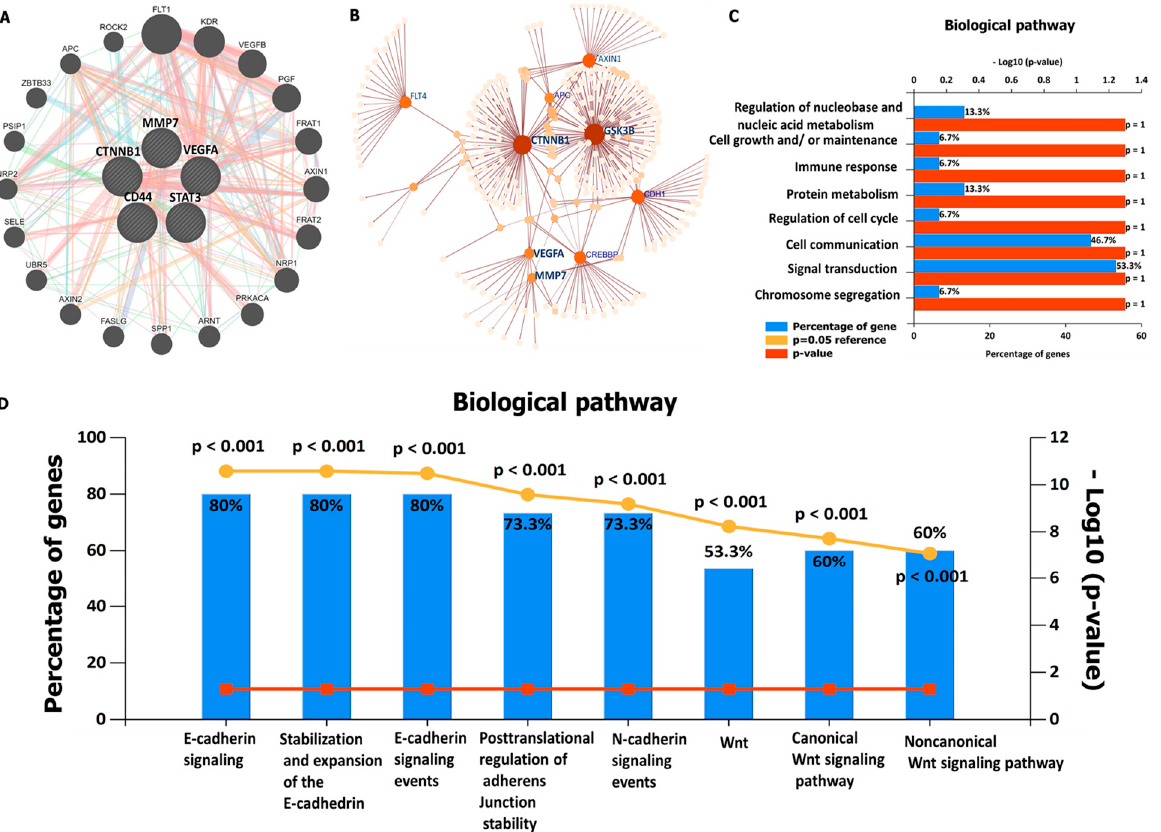
Figure 6. Correlation analysis network among Vascular endothelial growth factor- α ( VEGFA )/beta catenin ( CTNNB1 )/matrix metalloproteinase ( MMP)-7 /cluster of differentiation 44 (CD44) oncogenic signatures. Protein–protein interactions (PPIs) are displayed after considering the gene neighborhood, gene co-occurrence, and co-expression of the clustering network. ( A ) Gene–gene interactions (GGI) between VEGFA with CTNNB1 , VEGFA with MMP7 , VEGFA with CD44 , CTNNB1 with MMP7 , CTNNB1 with MMP7 , and CD44 with MMP7 . ( B ) KEGG pathway enrichment analysis from signaling network analysis. ( C ) Top 8 enriched biological processes. ( D ) Top 8 affected biological pathways, with p ‐ value < 0.05 considered significant.